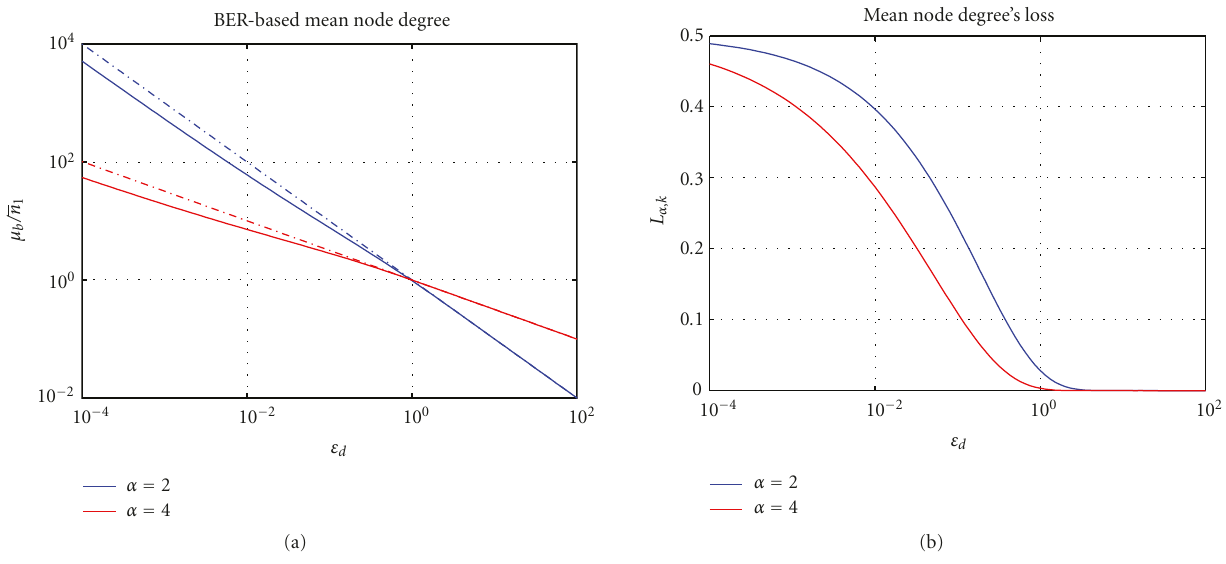
Figure 3: (a) The single-bit frame mean node degree is plotted as a function of ε d for two attenuation slope coe ffi cients ( α = 2 in blue, α = 4 in red), having k = 1. The maximal mean node degree owing to a perfect switched link of the same range is also provided (dashed lines). (b) Connectivity loss L α , k ( ε d ) due to BER in the same conditions. The asymptotic mean node degree having ε d → 0 (i.e., when the range tends towards infinity) is half the switched link value, because the BER tends towards 0 .